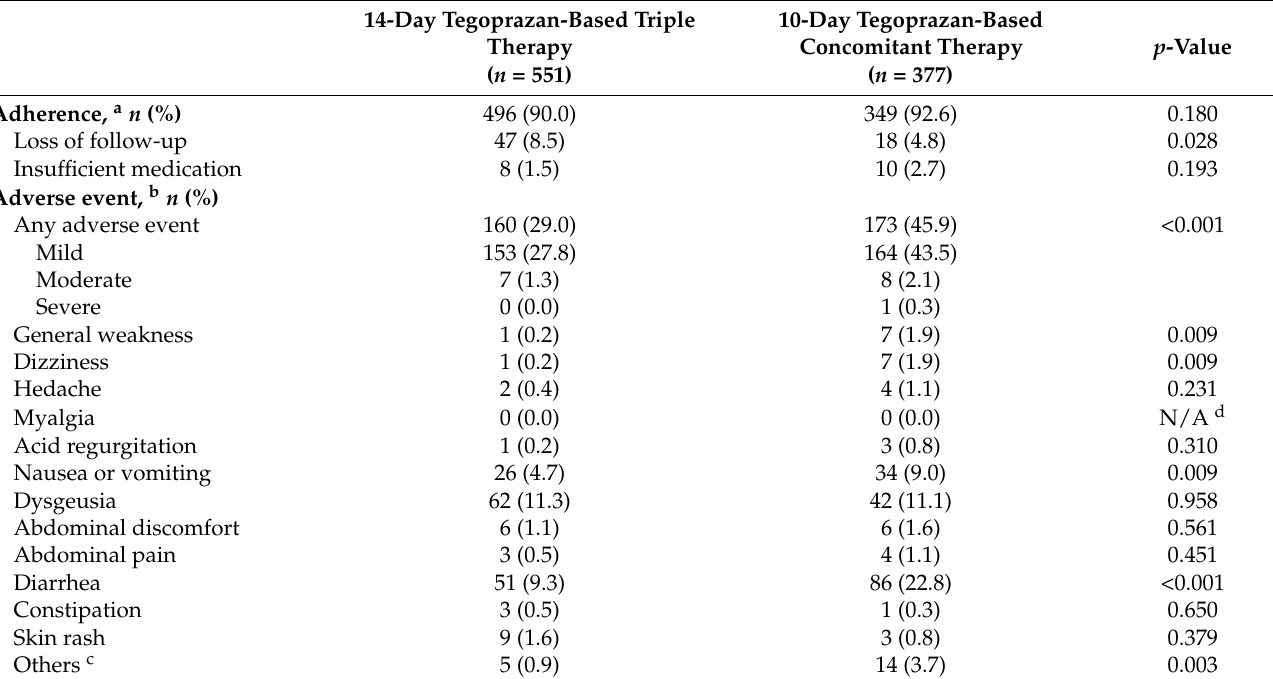
Table 3. Adherence and adverse events of first-line H. pylori eradication therapy.